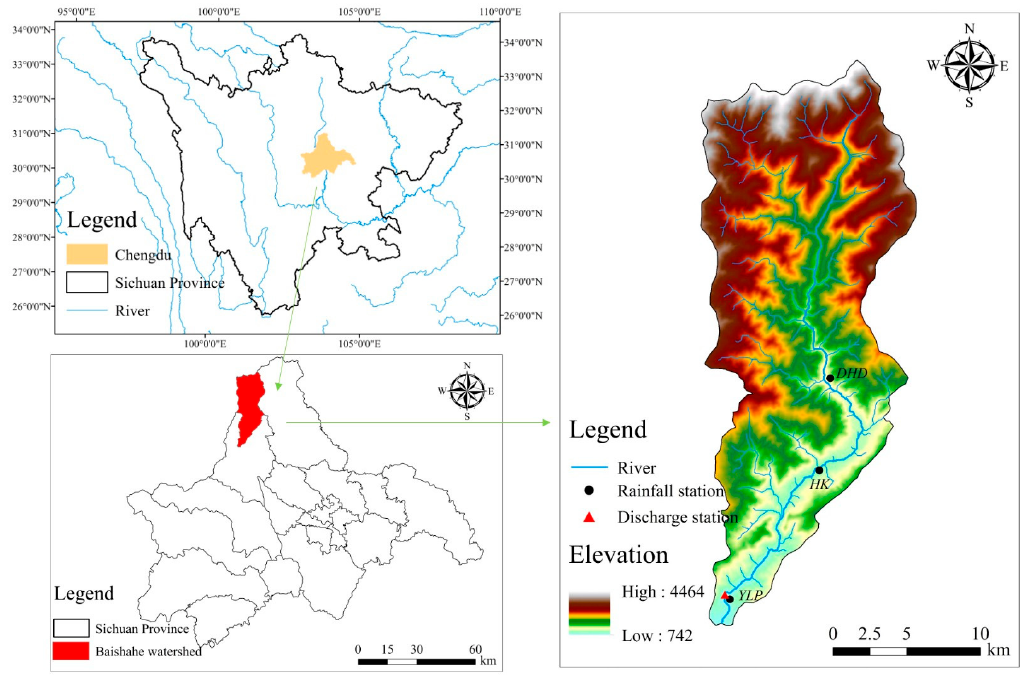
Figure 1. Study area.